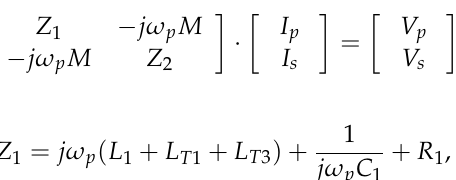
The active power P 1 and P 2 of the primary and secondary sides are